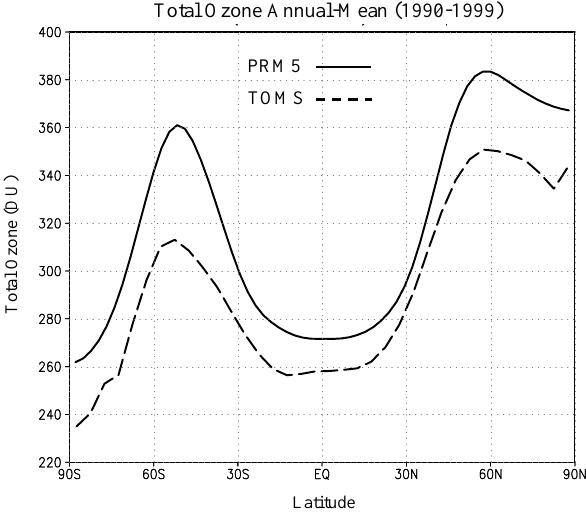
Fig. 5. Latitudinal distributions of the annual- and zonal-mean Fig.5 Latitudinal distributions of the annual- and zonal-mean total ozone (DU) for total ozone (DU) for the simulation (solid line) and observation the simulation (solid line) and observation (TOMS/SBUV) (dashed line) during the 1990s. For both polar regions beyond 60 ˚ , annual-mean values are calculated from (TOMS/SBUV) (dashed line) during the 1990s. For both polar re- those days when TOMS made measurements . gions beyond 60 ◦ , annual-mean values are calculated from those days when TOMS measurements were